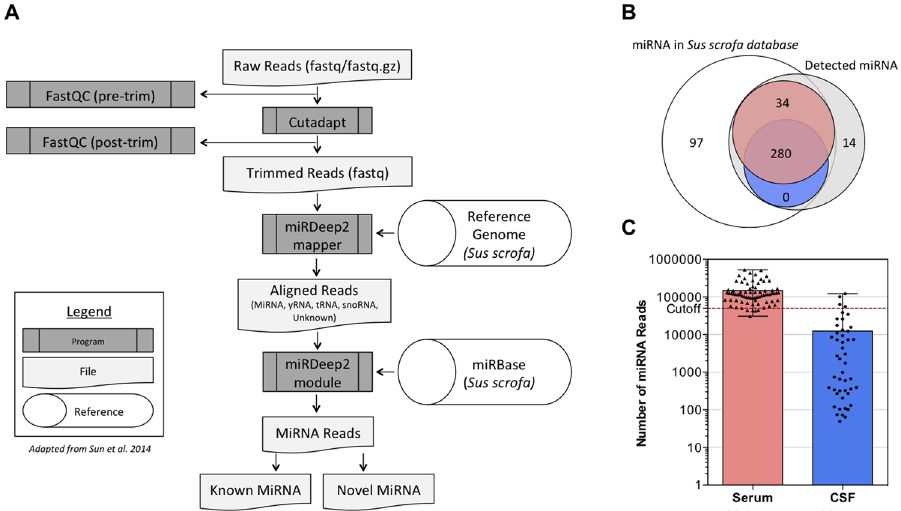
Figure 4. ( A ) Bioinformatic Pipeline. Raw reads were assessed for quality using FastQC before and after adapter trimming with the Cutadapt package. Trimmed reads were mapped to the pig ( Sus scrofa ) reference genome using the miRDeep2 mapper. Aligned reads were then mapped to the miRBase miRNA database using the miRDeep2 module. MiRDeep2 gives a matrix list of known and novel miRNA. ( B ) Detected miRNA. 314 out of the total 411 known Sus scrofa miRNA (white) were identified across all serum (red, 314 miRNA) and CSF (blue, 280 miRNA) samples, while 14 novel miRNA (grey) that do not yet exist in the Sus scrofa miRNA database were identified. ( C ) Number of miRNA reads for all samples. 60 serum samples (red) had over the cutoff of 50,000 miRNA reads, only 4 CSF (blue) samples had above 50,000 reads, and 11 CSF samples had over 10,000 miRNA reads.